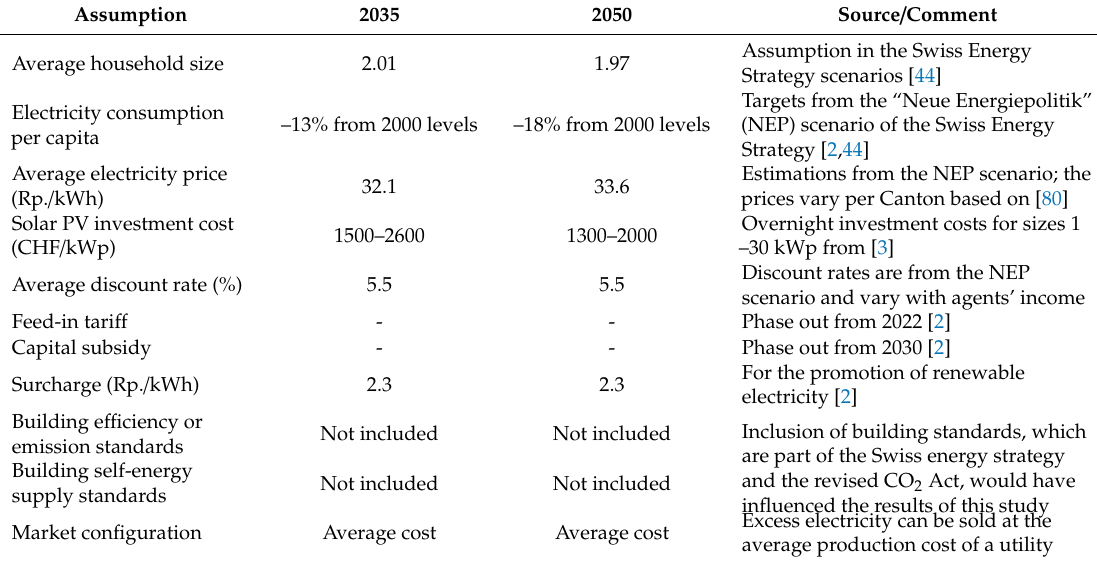
Table 2. Main assumptions of the Reference scenario.